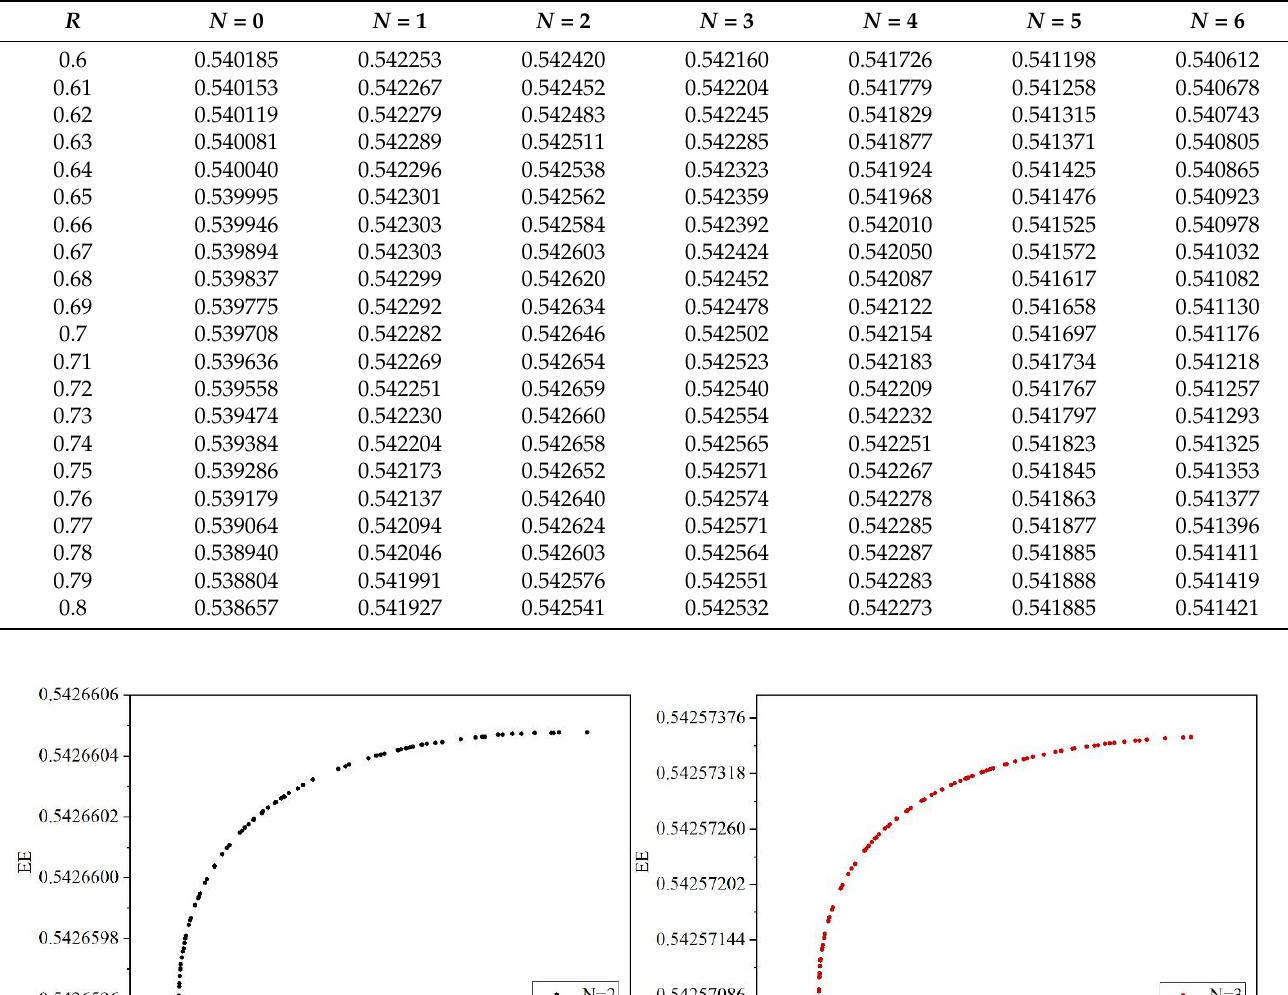
Table 3. Simulation results for energy efficiency.